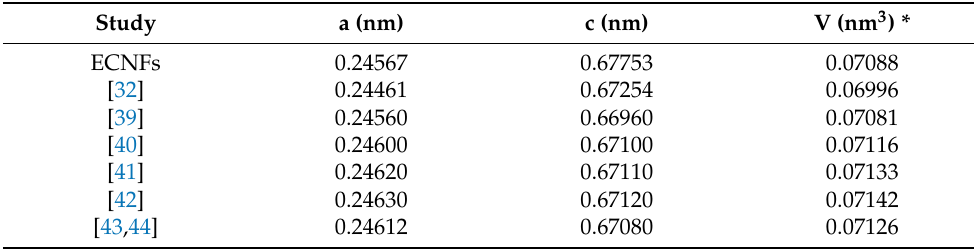
Table 1. Comparison of hexagonal graphite lattice parameters, cell volume, and density with data reported in the literature. Study a (nm) c (nm) V (nm 3 ) *